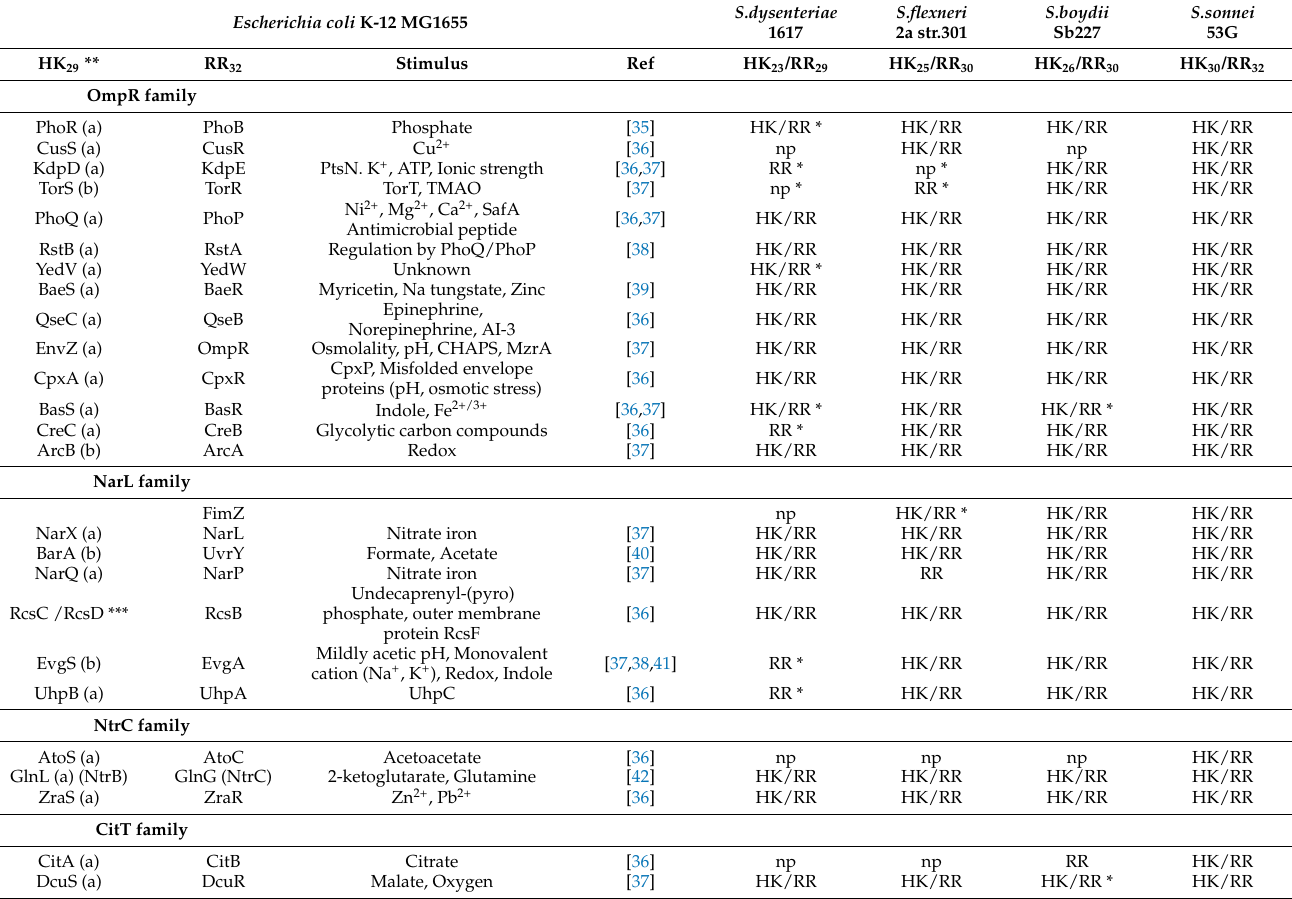
Table 1. Distribution of TCSs in Shigella